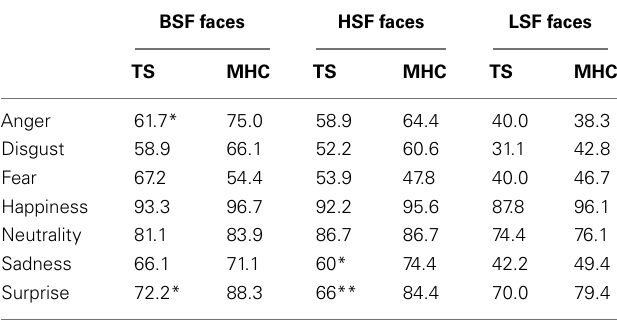
Table 4 |Average correct recognition rate forTS patients and MHC participants for each emotion and spatial frequency